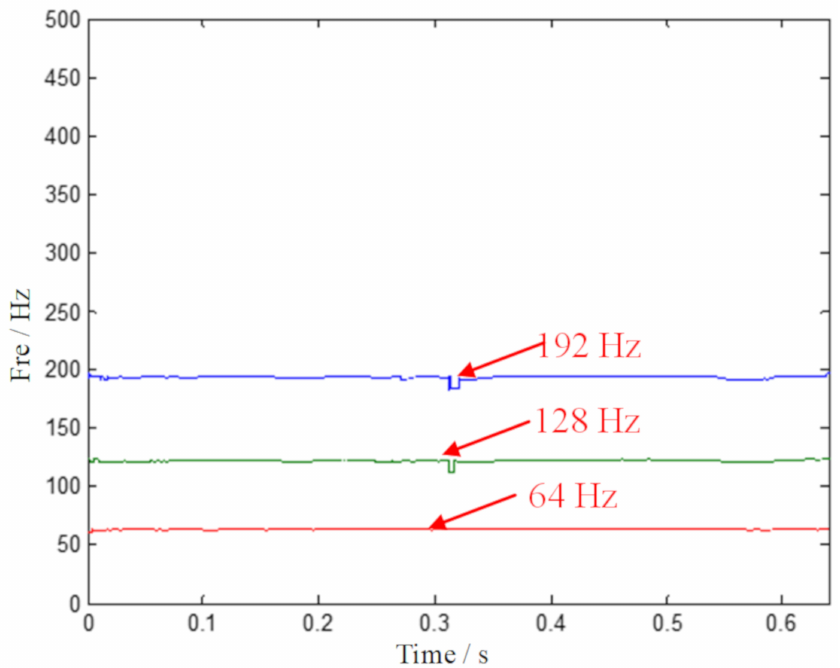
Figure 19. The multiple ridge identification by the proposed ISECT